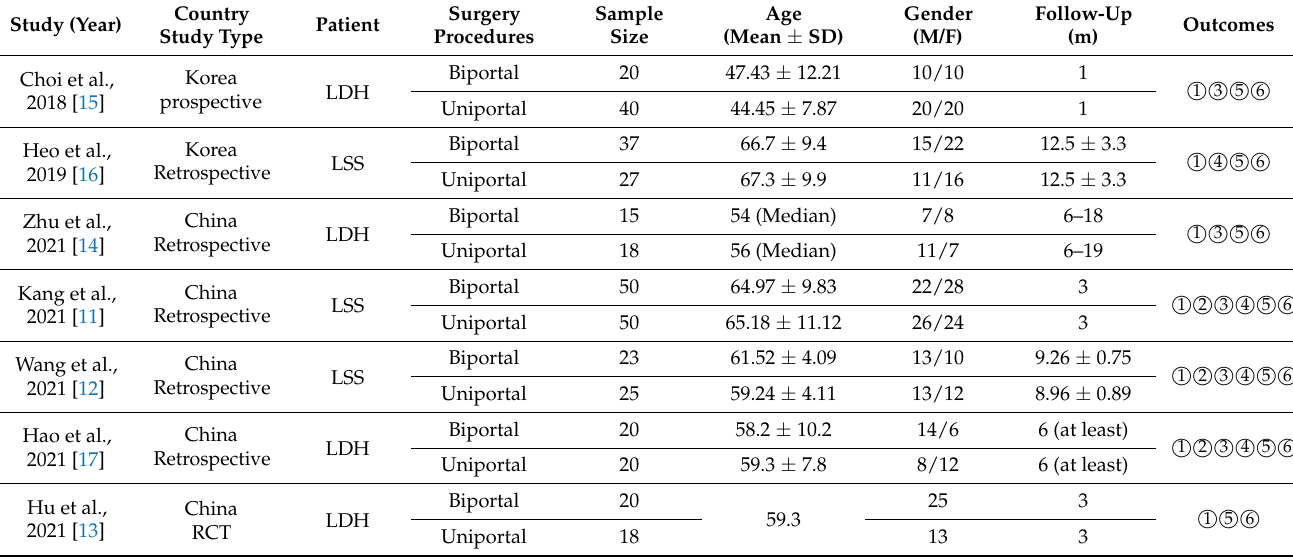
Table 1. Characteristics and Primary Outcomes of Included